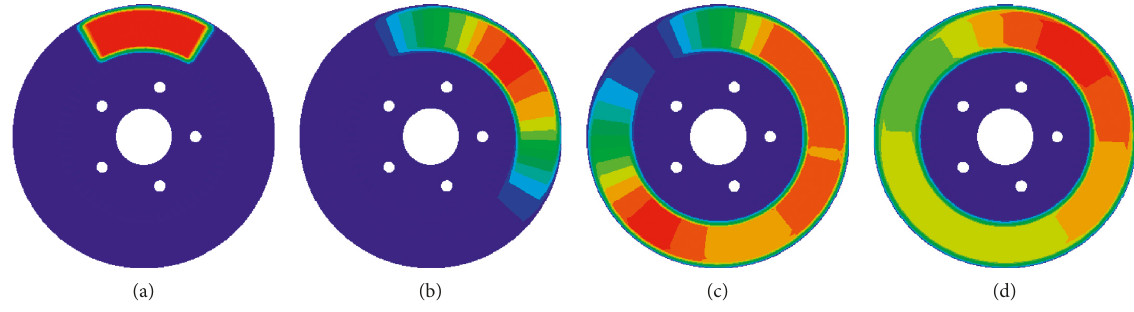
Figure 10: Heat flux rotated on the disc brake.